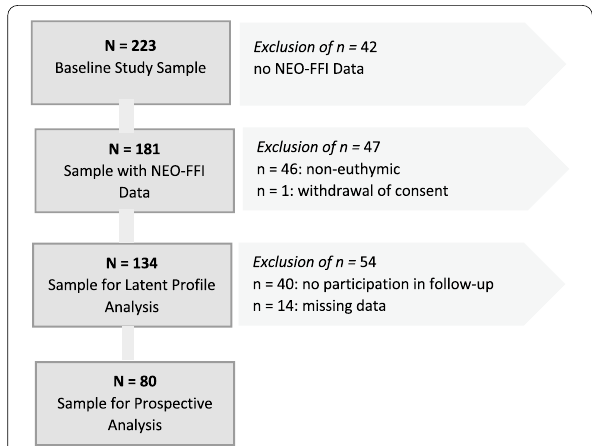
Fig. 1 Flowchart of the sample including reasons for the exclusion of patients. NEO-FFI (NEO Five-Factor